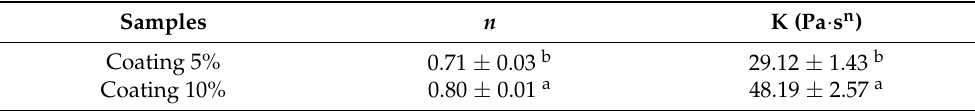
Table 2. Flow behavior index ( n ) and consistency index (K) of the coatings at two concentrations, obtained with Power Law model applied on viscosity data.